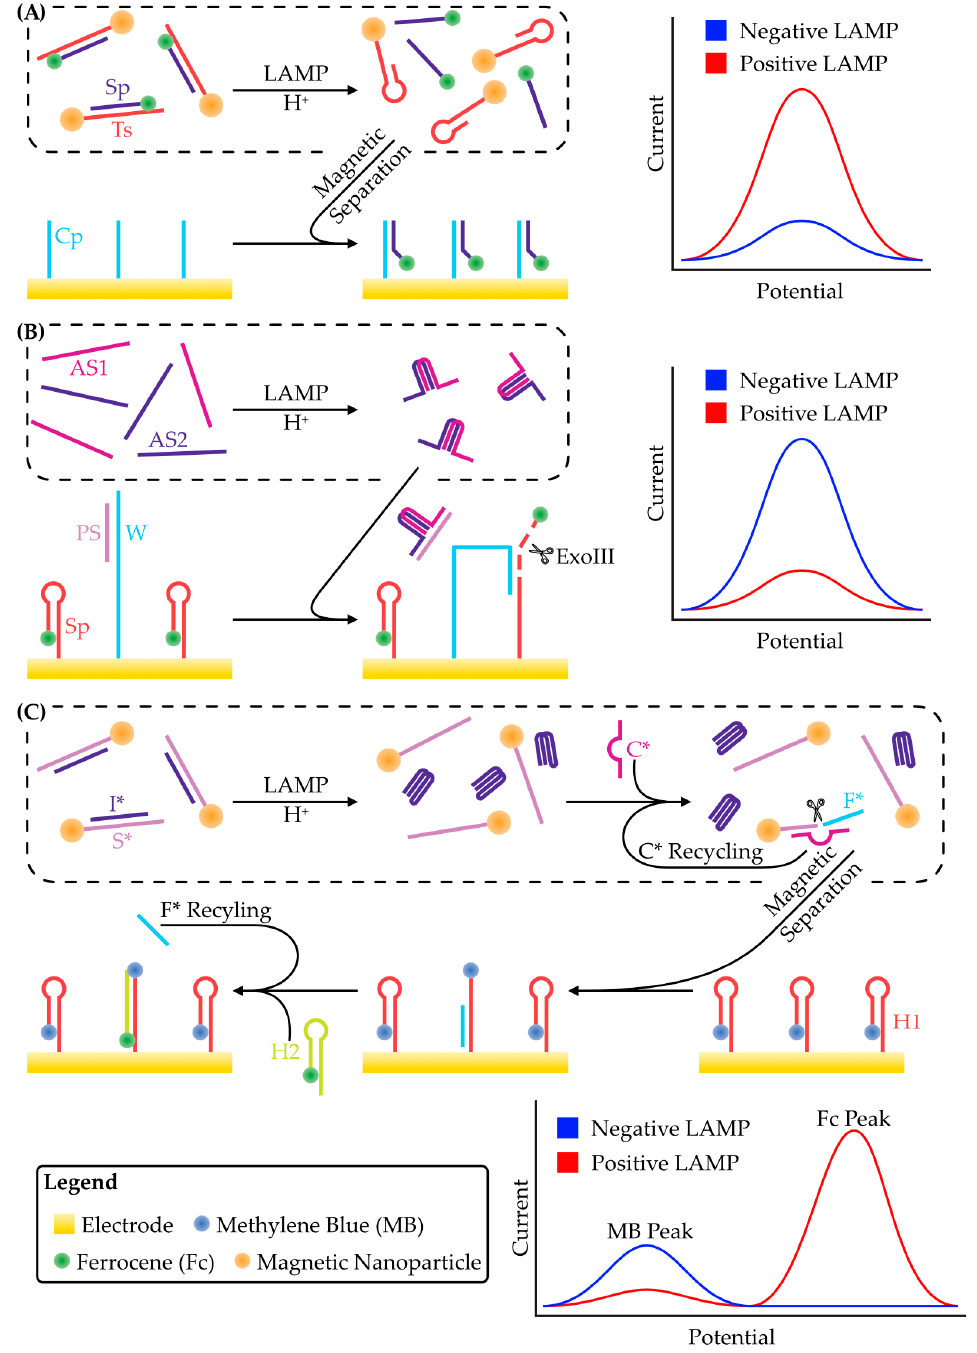
Figure 5. Schematic strategies for the detection of protons produced through DNA replication during LAMP. ( A ) An oligonucleotide, Ts, is conjugated to a magnetic nanoparticle. Another oligonucleotide, Sp, is conjugated to ferrocene and hybridized to Sp. This duplex is pH sensitive, and protons produced during LAMP cause it to denature. Ts is removed by magnetic separation and the purified Sp is hybridized to another oligonucleotide, Cp, that is functionalized to the electrode. This concentrates the Sp-bound ferrocene at the electrode surface and produces a large peak faradaic current, as shown in the schematic voltammogram. Adapted from [78]. ( B ) The electrode is functionalized with two oligonucleotides: W and Sp. Sp is conjugated to ferrocene and forms a hairpin structure, bringing ferrocene in close contact with the electrode. W is blocked by another oligonu- cleotide, Ps. Protons produced during LAMP cause two oligonucleotides (AS1 and AS2) to form an i-motif. This i-motif has a region complementarity with Ps and causes its release from W via